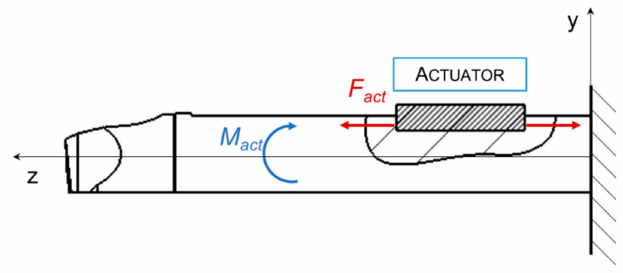
Figure 3. Chosen actuation